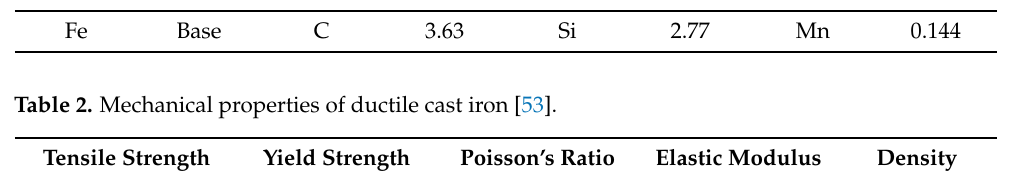
Figure 1. The considered automotive cast iron knuckle [53,55]. Table 1. Chemical composition (wt%) of the cast iron steering knuckle [53].